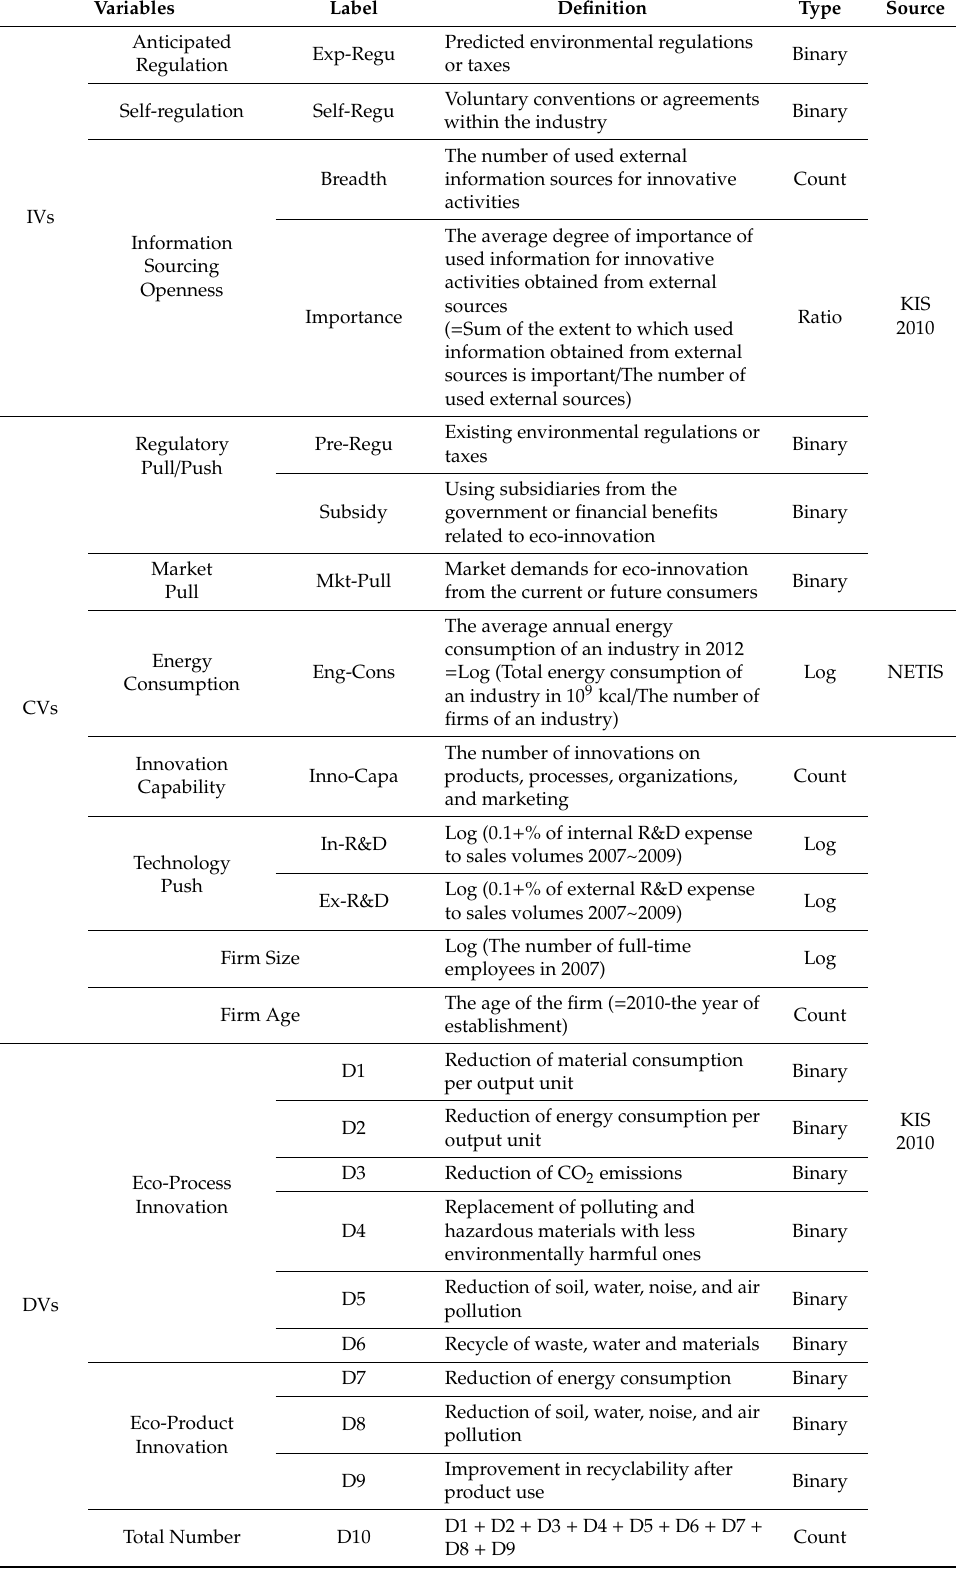
Table 1. Definitions and Measurements of